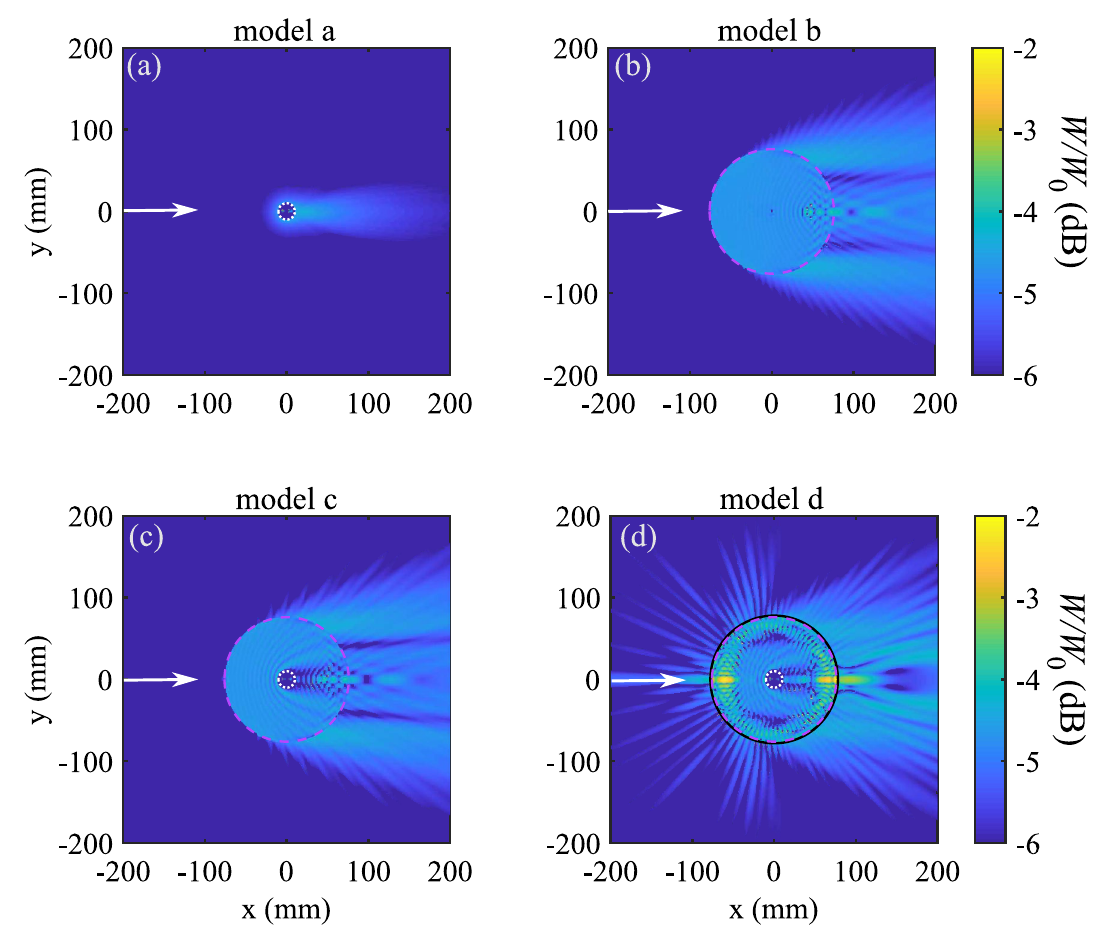
Figure 4. Calculations of the longitudinal acoustic energy density W for the four different model scatterers at 150 kHz. W 0 is the incident energy density. The white dotted line represents the limits of the swim bladder, f = the dashed pink line the flesh layer and the solid black line the thin scales and bones layer. White arrows indicates the direction of the incident plane